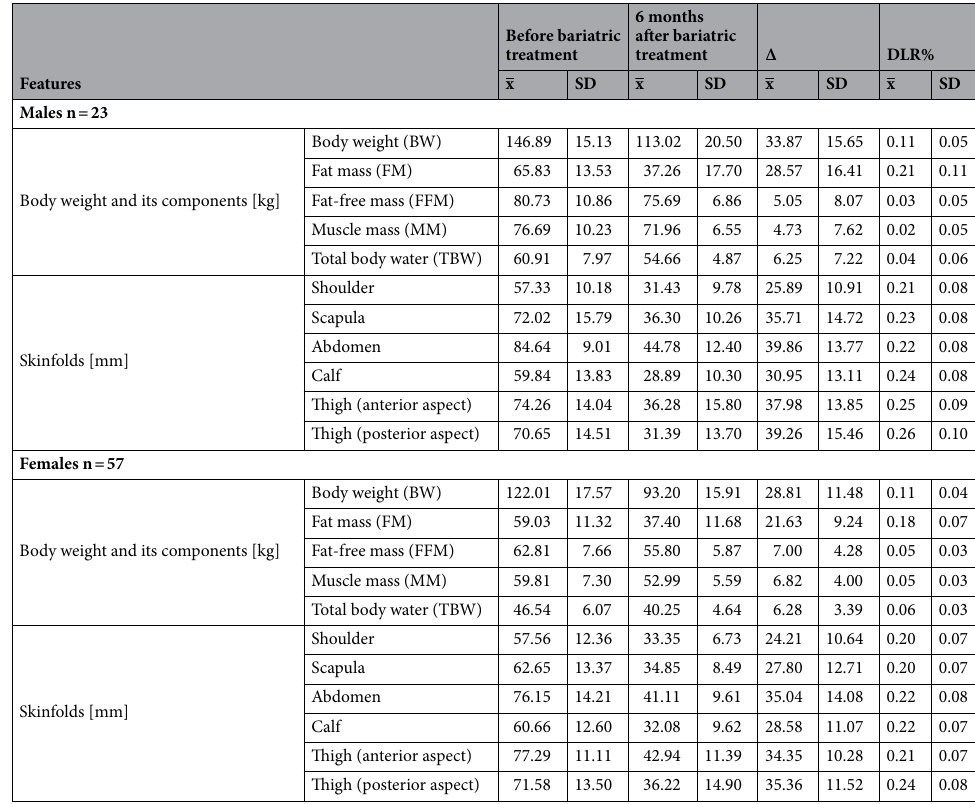
Table 4. Anthropometric characteristics of obese men and women undergoing bariatric procedures. x , mean; SD, standard deviation; Δ, difference between measurements before bariatric treatment and 6 months after bariatric treatment; DLR%, daily percentage levels of